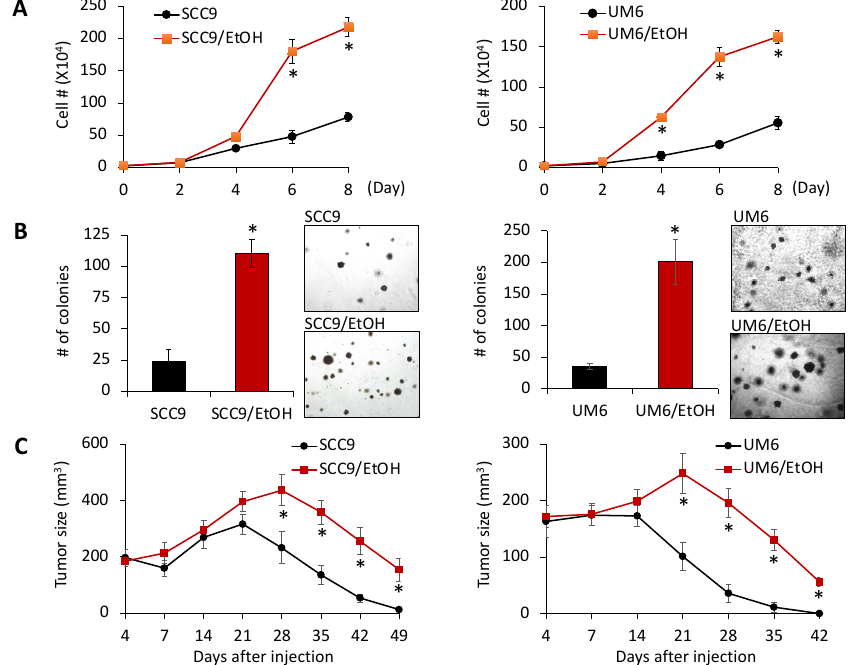
Figure 1. Chronic EtOH exposure increases tumor growth of OSCC both in vitro and in vivo. ( A ) Effect of chronic EtOH exposure on proliferation capacity of OSCC was determined by cell counting. Passage-matched controls, SCC9 and UM6, were used to compare with SCC9/EtOH and UM6/EtOH, respectively. The assay was performed in the absence of EtOH. * p < 0.001 compared to untreated controls by Student’s t -test. ( B ) Effect of chronic EtOH exposure on anchorage independent growth ability of OSCC was determined by soft agar assay. The assay was performed in the absence of EtOH. Data are means ± SD of triplicate experiments. * p < 0.001 compared to untreated controls by Student’s t -test. ( C ) Effect of chronic EtOH exposure on in vivo tumorigenicity of OSCC was determined by xenograft tumor assay. * p < 0.001.